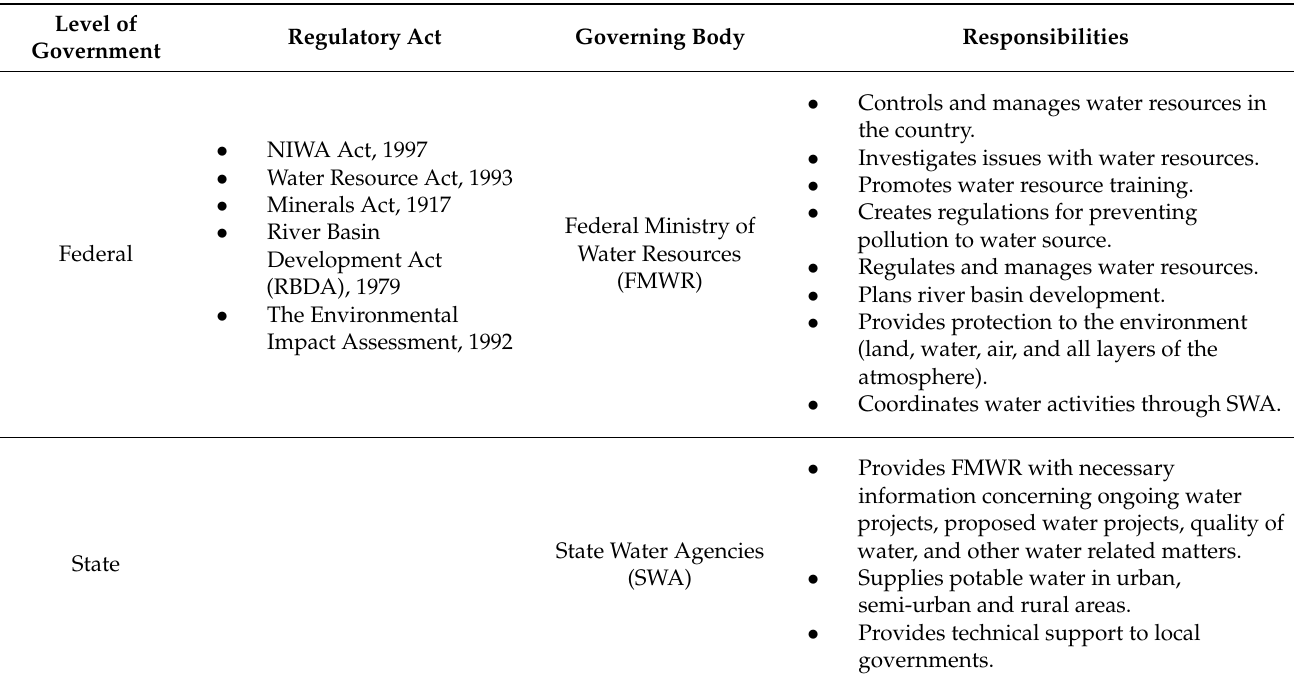
Table 1. Overview of water governing bodies in Nigeria and their